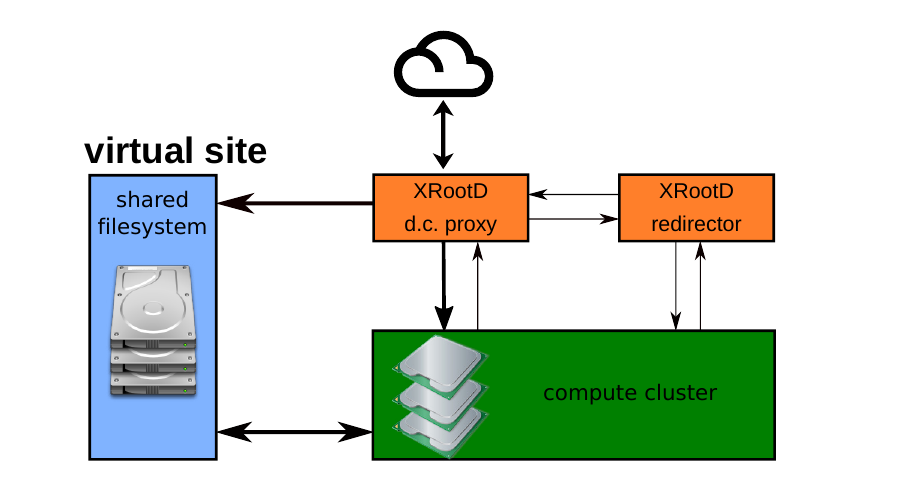
Figure 2. Disk Caching Proxy